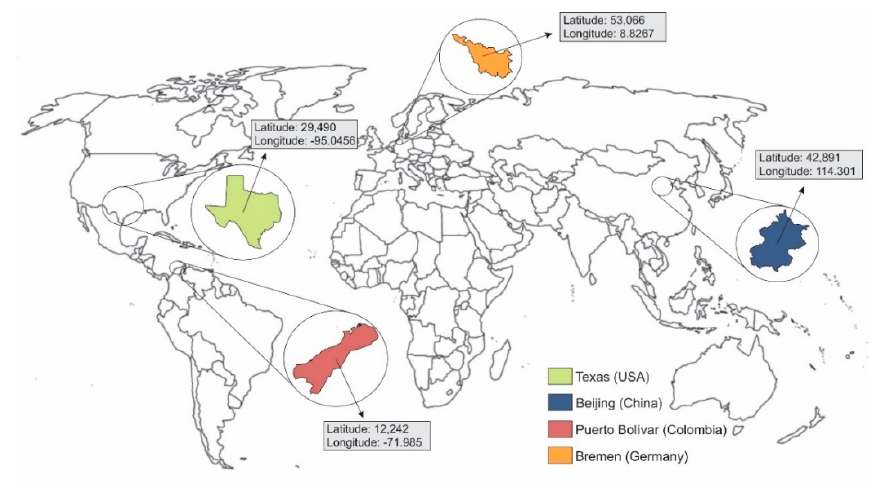
Figure 1. The geographical location of the studied regions.